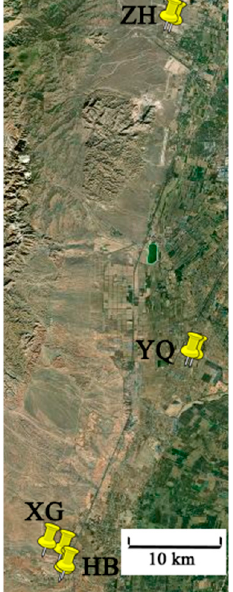
Figure 1. The geographical locations of the four sub-regions.